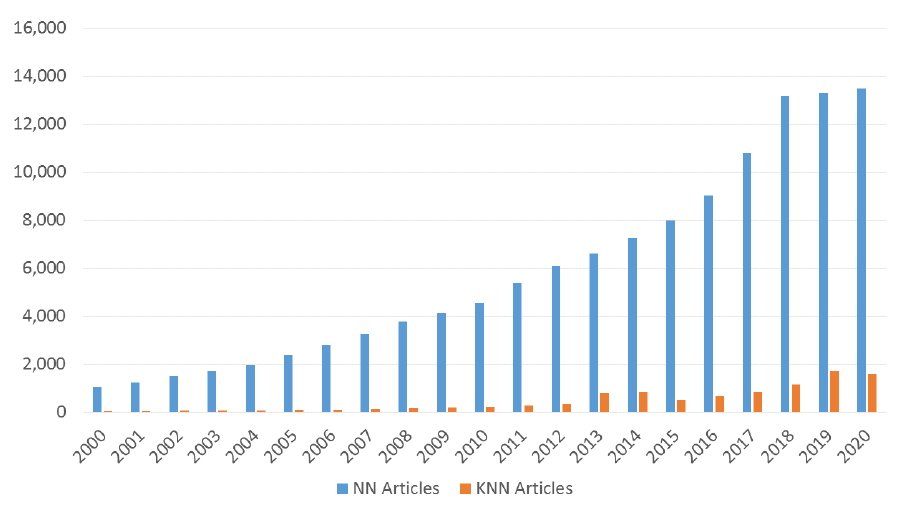
Figure 11. The number of indexed articles for KNN and Neural Network used in rainfall forecasting from Google Scholar as of 20 Junuary